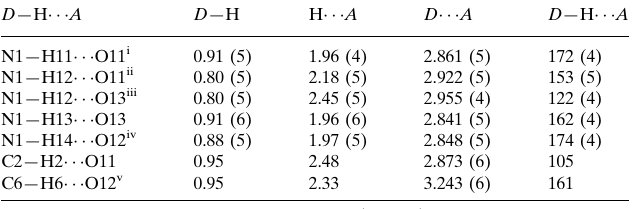
Hydrogen-bond geometry (A˚ , (cid:3)